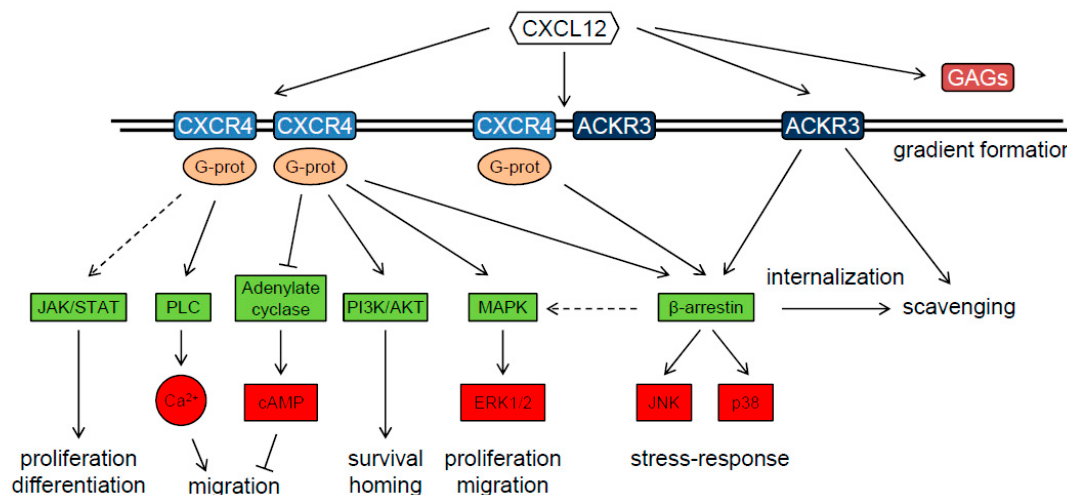
Figure 3. Schematic overview of the CXCL12-CXCR4-ACKR3 signaling cascade. Intermediate kinases